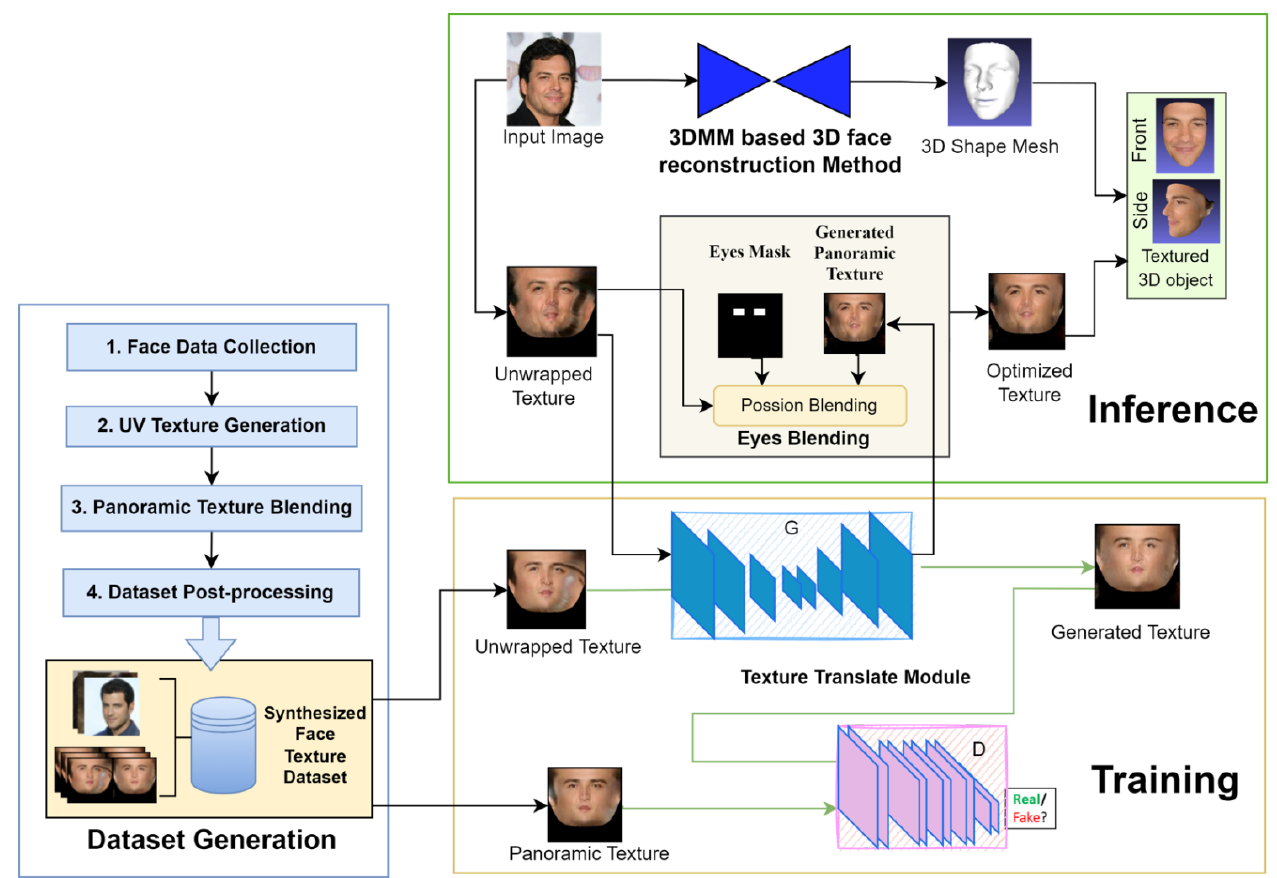
Figure 1. Overview of the panoramic texture generation method for 3DMM-based 3D face recon- struction.